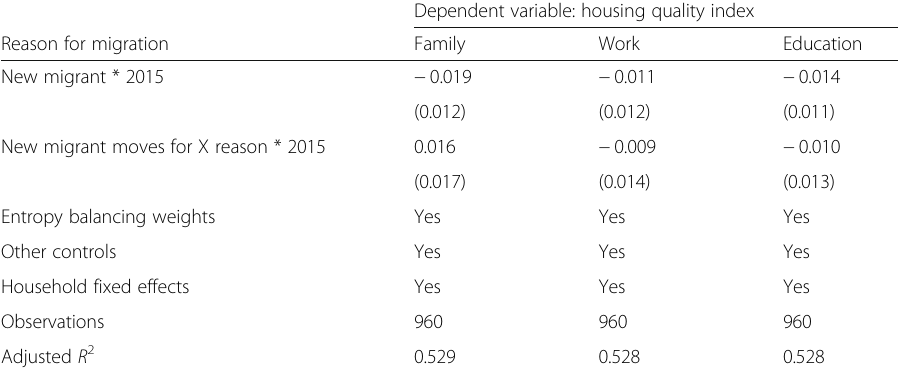
Table 8 Testing for heterogeneity by migration motives Dependent variable: housing quality